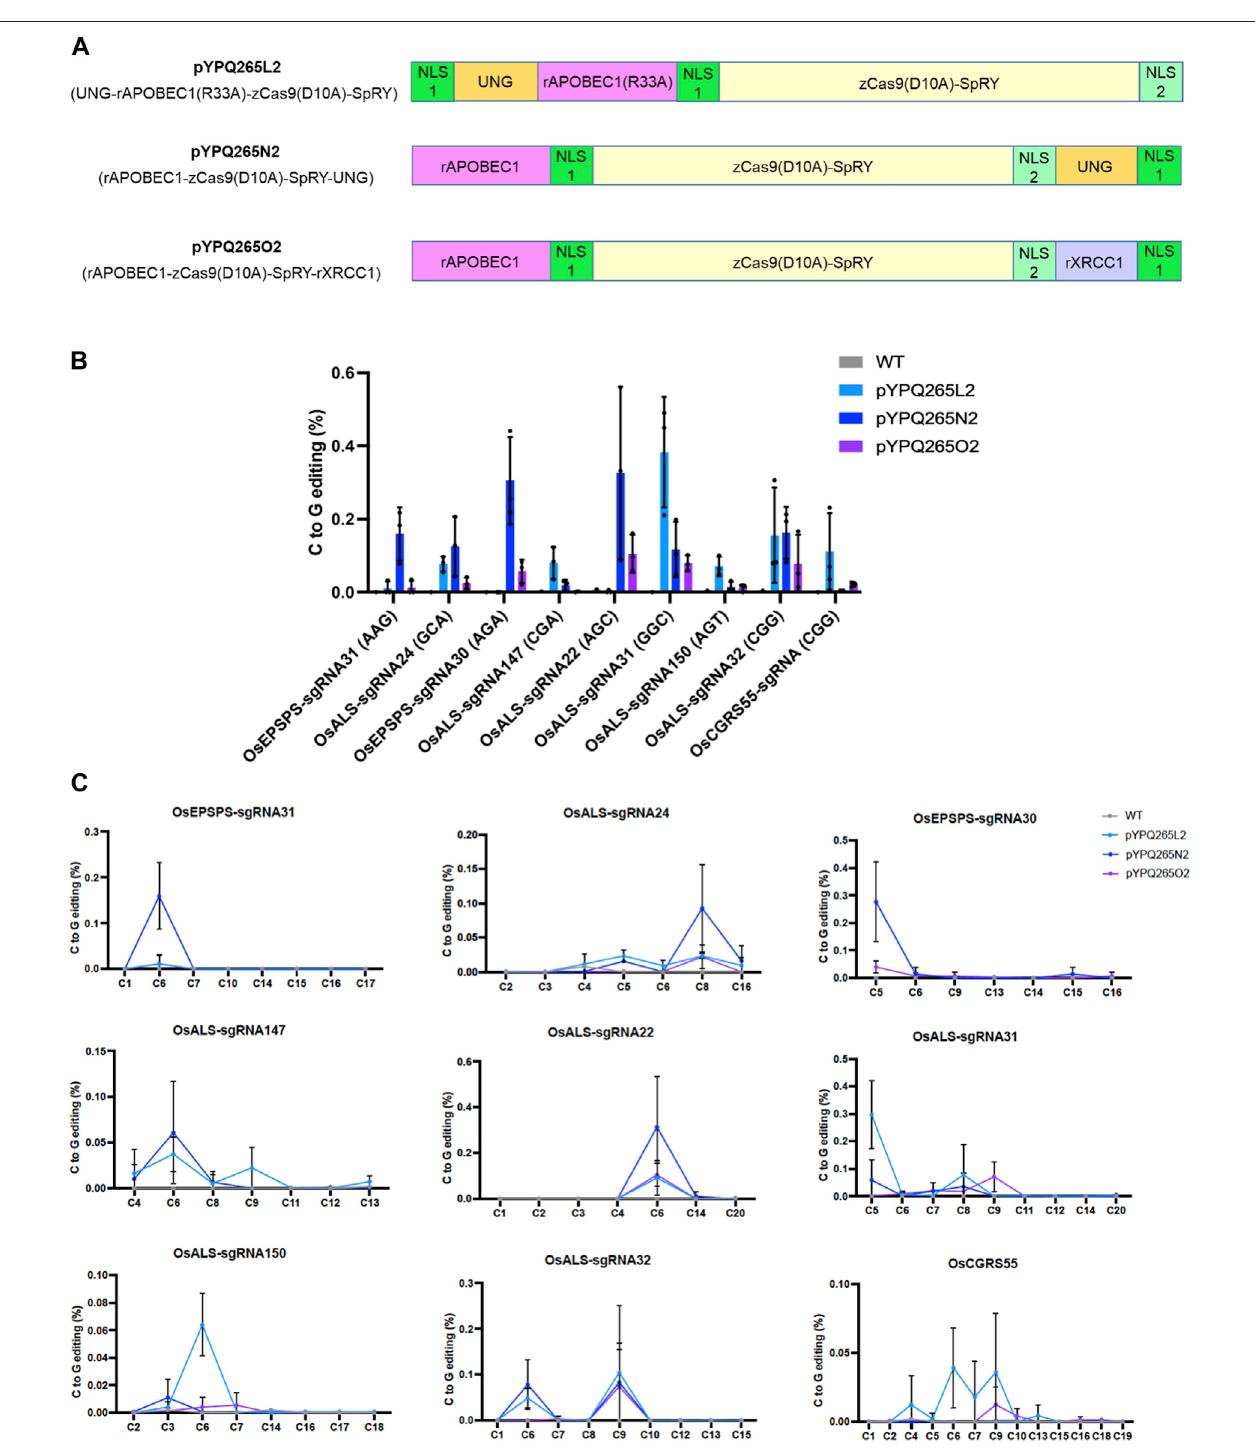
FIGURE 3 | Assessment of three SpRY-based CGBEs in rice protoplasts. (A) Diagram of three SpRY-based CGBEs. Note each NLS is indicated by a green box. NLS 1 is a monopartite SV40 nuclear localization signal and NLS 2 is a bipartite nuclear localization signal of nucleoplasmin. Both NLS1 and NLS2 are recognized by importin α . (B) NGSquanti fi cationofC-to-Geditingatninetargetsitesinthericegenomes. (C) NGSanalysisofeditingwindowsbydifferentSpRY-basedCGBEsacross different target sites. The error bars represent standard errors of three biological replicates.